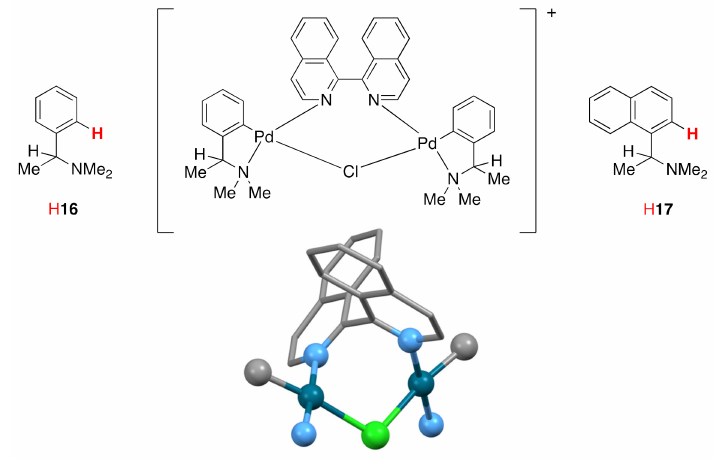
κ CN }](ClO 4 ) is shown. Only the C and N donor atoms of the cyclometalated 16 ligands are shown. Hydrogen atoms have been omitted for clarity and donor atoms and the metal centers are depicted as